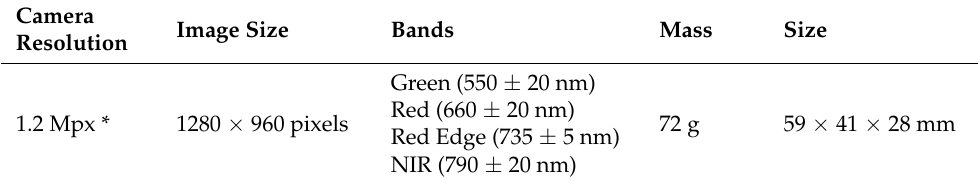
Table 1. Properties of the multispectral sensor Parrot